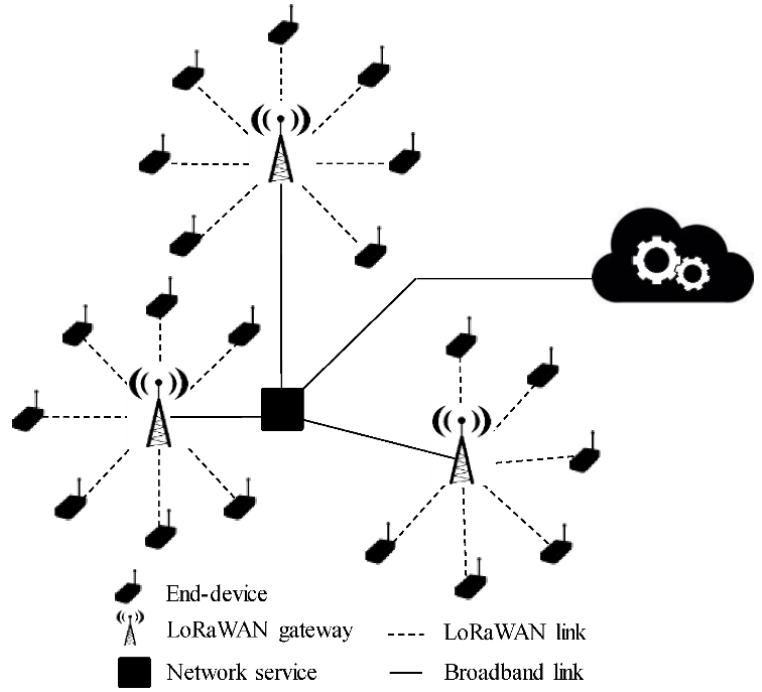
Figure 4. Stars-of-stars topology.